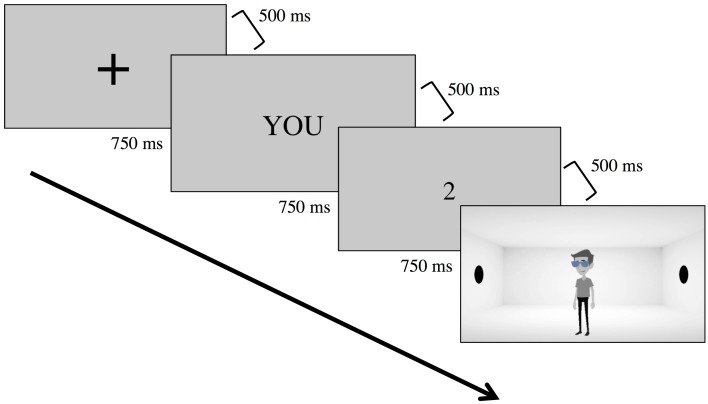
Depiction of Study 2’s procedure.Participants first saw a fixation cross followed by a perspective indication for either self (“YOU”) or other (“HIM”) trials. Participants then saw a number indication followed by an image of the avatar. At this point, participants then had 2000 ms to respond “yes” or “no” by clicking buttons on a computer.